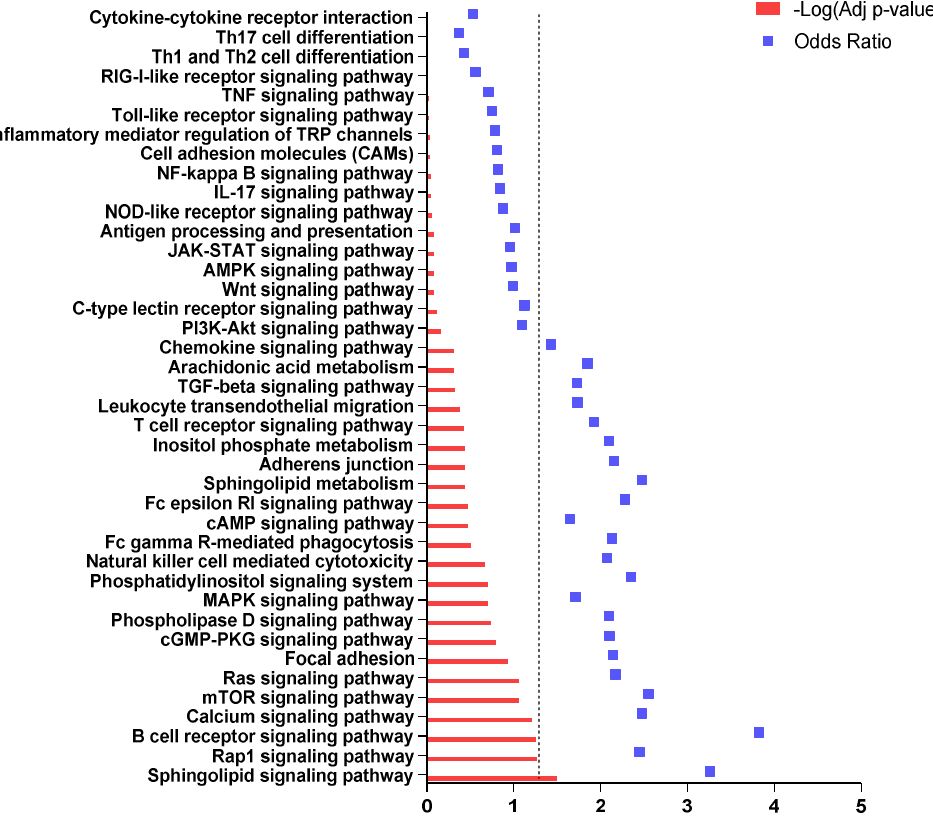
Figure 3. Immune-related pathways enriched in brain samples from ASD patients. Dotted line indicates the threshold of significance.